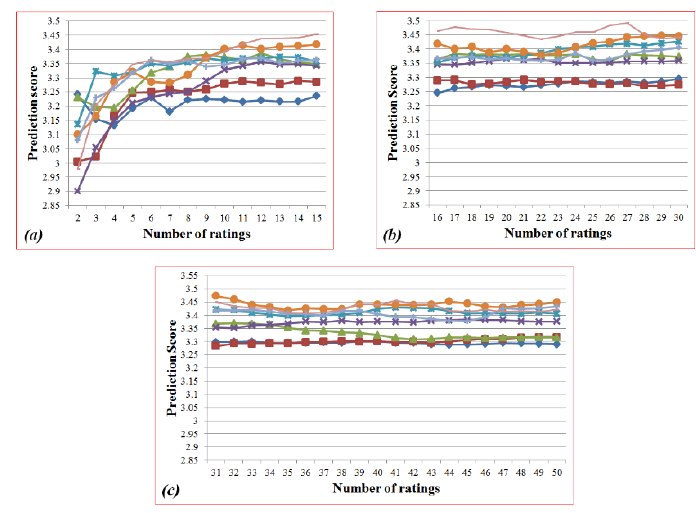
Figure 10. Sub-graphs of Figure 9: ( a ) the ranges from 2 to 15; ( b ) from 16 to 30; ( c ) from 31 to 50.